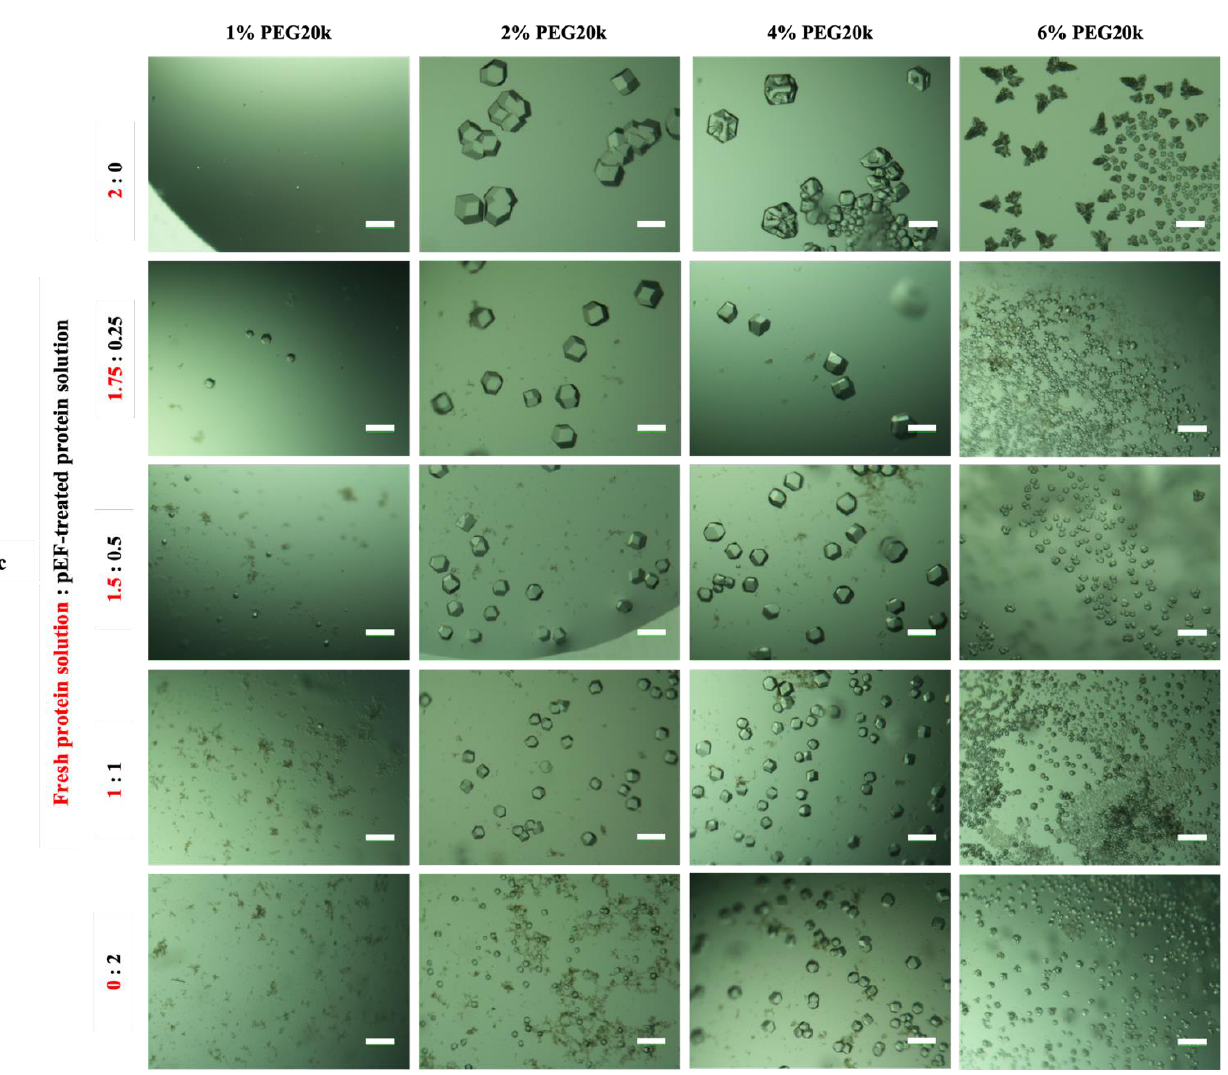
Figure 8. ( a ) Forty microliters of 4 mg/mL GI in a buffer of 10 mM MES pH 6.5, 1 mM DTT and 50 mM MgCl 2, incubated in a quartz cuvette for 30 min without and with the application of a pEF. The scale bar corresponds to 50 μ m. ( b ) GI crystals obtained from droplets with a final concentration of 2 mg/mL GI, and different ratios ( v / v ) of fresh protein solution seeded with a pEF-treated protein solution in 10 mM MES pH 6.5, 1 mM DTT and 50 mM MgCl 2 buffer. PEG20k in the same buffer with GI was applied as crystal lization precipitant. Scale bar is 200 μm. ( c ) Magnified view of crystals formed in each droplet, and the scale bar corresponds to 100 μm. All droplets were recorded via an optical microscope after 24-hour incubation at 20 °C.